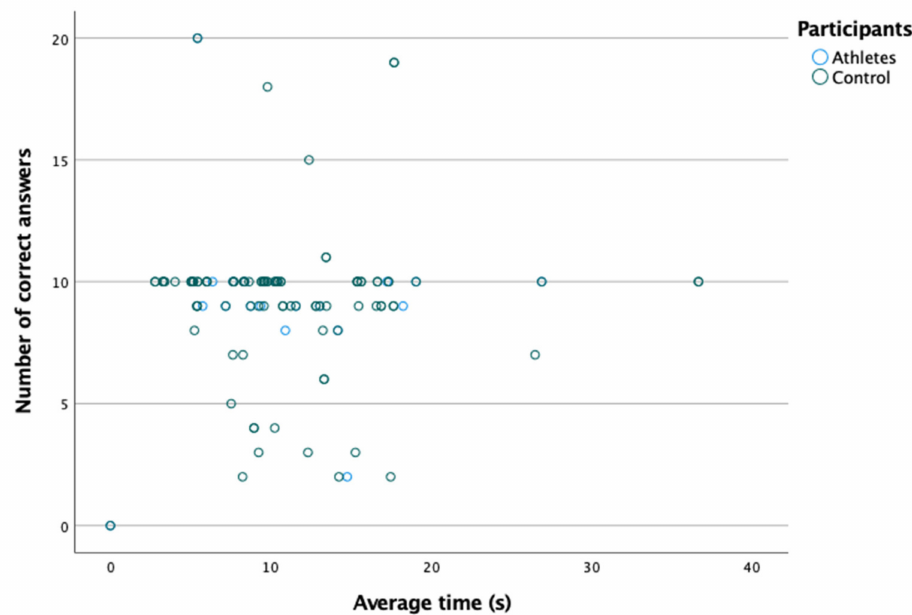
Figure 2. Absence of relationship between the number of correct answers and the average time.